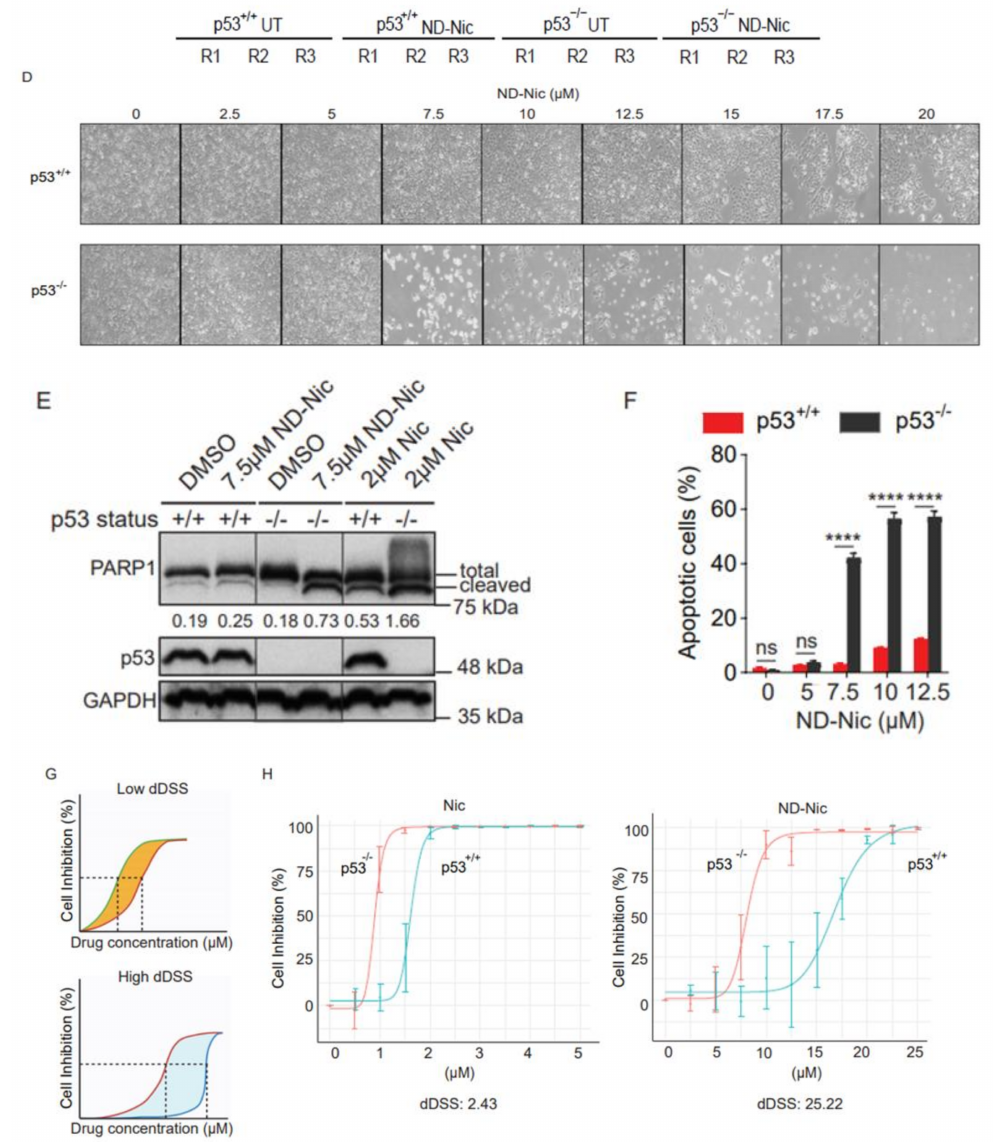
Figure 1. Nitro-deficient niclosamide retains the selective killing capacity against p53-deficient cells. ( A ) Chemical structures of niclosamide (Nic), 5-chloro-N-(2-chloro-4-nitrophenyl)-2-hydroxybenzamide, and nitro-deficient niclosamide (ND-Nic), 5-chloro-N-(2-chlorophenyl)-2-hydroxy-benzamide. The red box highlights the nitro group on the aniline motif that is eliminated in the ND-Nic analog. ( B ) p53 protein expression in HCT116 p53 +/+ and p53 − / − cells detected by Western Blot. Hsp90 was used as the loading control. ( C ) Crystal violet staining compares the survival of human colon carcinoma HCT116 p53 +/+ and p53 − / − cells 7 d post recovery from 48 h treatment with Nic and ND-Nic. The graph quantifies the colony intensity of the crystal violet staining results. Black scale bar at 37 mm. ( D ) Bright field microscopic images of HCT116 p53 +/+ and p53 − / − cells treated with ND-Nic are shown at indicated concentrations after 48 h. Black scale bar at 100 µ m. ( E ) Protein expression of apoptosis marker, cleaved PARP1 was detected by Western Blot in HCT116 p53 +/+ and p53 − / − cells treated with either DMSO, 2 µ M Nic or 7.5 µ M ND-Nic for 48 h. GAPDH was used as the loading control. Ratios of intensities of cleaved PARP1 over full-length PARP1 are shown quantified at the bottom. ( F ) Annexin-V-Alexa Fluor 568 is used to detect the early and late apoptotic cells induced in response to ND-Nic in HCT116 p53 +/+ and p53 − / − cells using flow cytometry. HCT116 p53 +/+ and p53 − / − cells treated with 0, 5, 7.5, 10, and 12.5 µ M ND-Nic for 48 h. Error bars represent ± SD of at least 3 independent experiments. t -test was used to determine significance (****, p < 0.0001; ns, p > 0.05). ( G ) Schematics of the low and high differential drug sensitive score (DSS) plotted from cell inhibition (%) against drug concentration ( µ M) (refer to Materials and Methods). dDSS denotes the differential drug response of two cell lines tested in comparison. ( H ) Cell inhibition (%) was assessed in HCT116 cells treated with Nic and ND-Nic at the indicated concentrations for 48 h using WST-1 cell proliferation assay. Raw data were converted into R programming language and plotted to generate area under the curve (AUC) for the calculation of differential AUC (dAUC) and differential drug sensitivity score (dDSS). Approximate IC 50 values are IC 50(Nic) p53 +/+ = 1.6 µ M; p53 − / − = 0.9 µ M) and IC 50 (ND-Nic) p53 +/+ = 16.7 µ M; p53 − / − = 8.3 µ M). Error bars represent ± SD of at least 3 independent